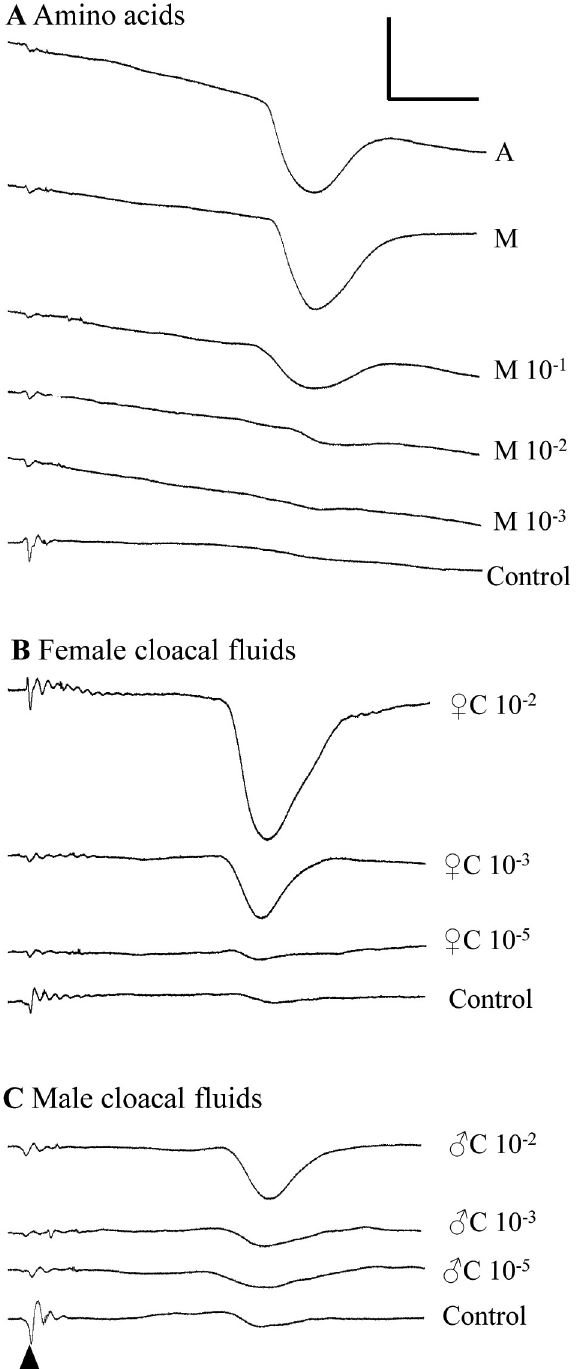
Fig 3. Sample EOG recordings. EOG traces are shown in response to (A) amino acids, (B) female cloacal fluids, and (C) male cloacal fluids. The stimulus was injected into the perfusion line at the beginning of each trace (indicated with the black caret), creating a small stimulus artifact, with EOG response occurring 6–8 seconds later (large downward deflections). Stimuli and relative concentration are indicated to the right of each trace (A is 1 mM alanine; M is 1 mM methionine; C is cloacal fluid). Control in (A) was saline; controls in (B) and (C) were cloacal-specific controls (saline passed through the cloacal fluid collection process). Scale bar is 1 mV (vertical) and 3 s (horizontal). Data were from Frog 8; summary data can be found on subsequent